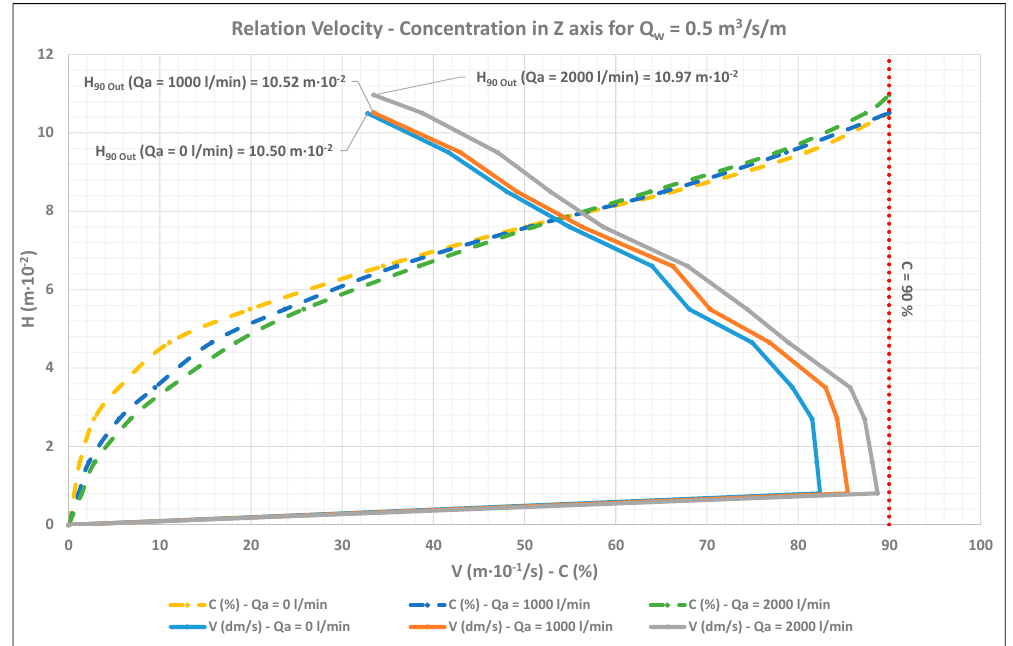
Figure 9. Relation between depth (H) and velocity (V)—Concentration (C) profiles in scenario 3 (Q w = 0.5 m 3 /s/m).